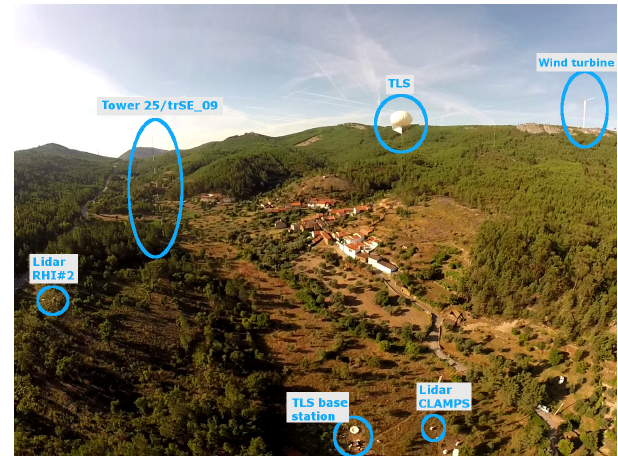
Figure 1. Map of the Vale do Cobrão. The gray structures are sur- face elements (mostly forest) obtained from a high-resolution lidar elevation scan 1 year before the campaign. The small map in the top-left corner gives a wider overview of the surrounding area. The dashed lines show the cross sections for measurements with the li- dar instruments used in this study.